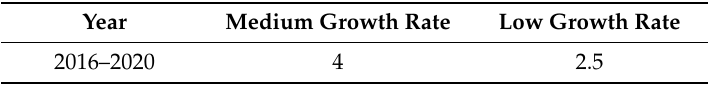
Table 6. Transportation possession quantity growth of Beijing form 2016 to 2020 (%).